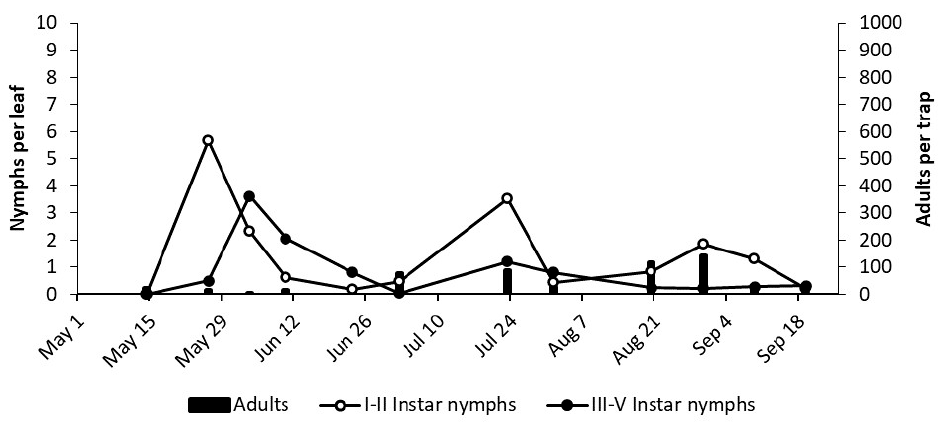
Figure 6. The phenology of E. vulnerata in AO vineyard in the growing season of 2017. Arrow indi ‐ cates pyrethrins treatment.